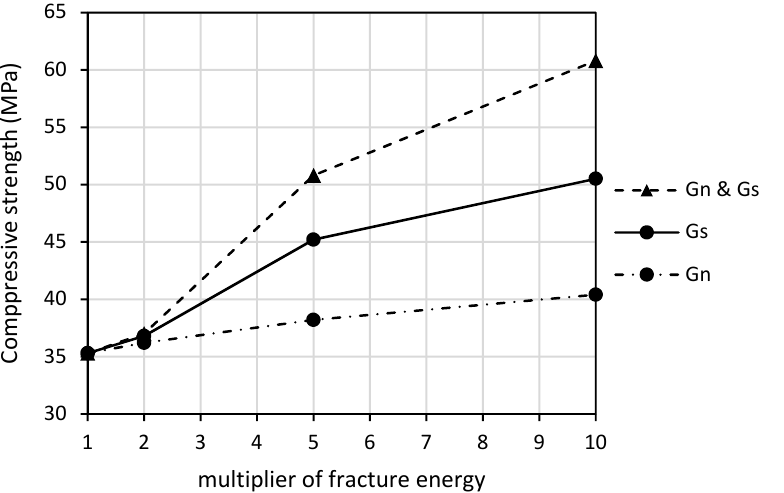
sample is depicted in Figure 15. Bilinear post-peak softening was used, as in the base